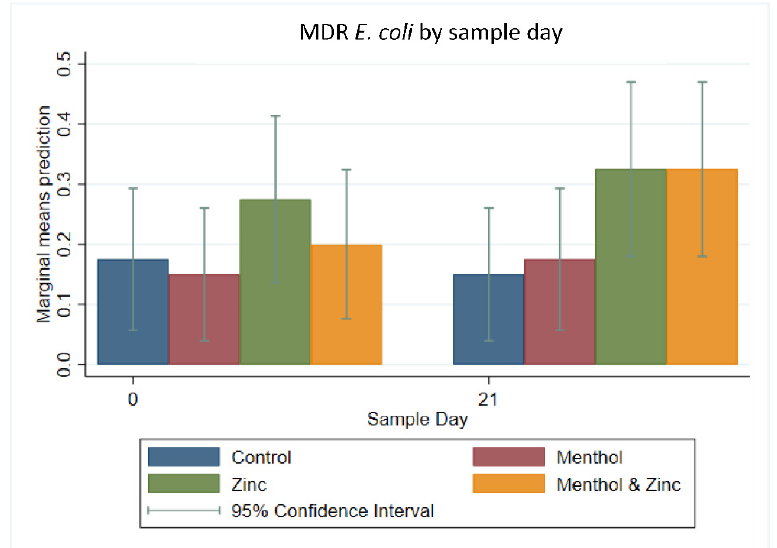
Figure 7. Marginal means with 95% confidence intervals of a 2 × 2 × 2 multi-level mixed logistic regression model, using factors of zinc, menthol and sample day on the binary outcome of multi-drug resistant (MDR) E. coli .